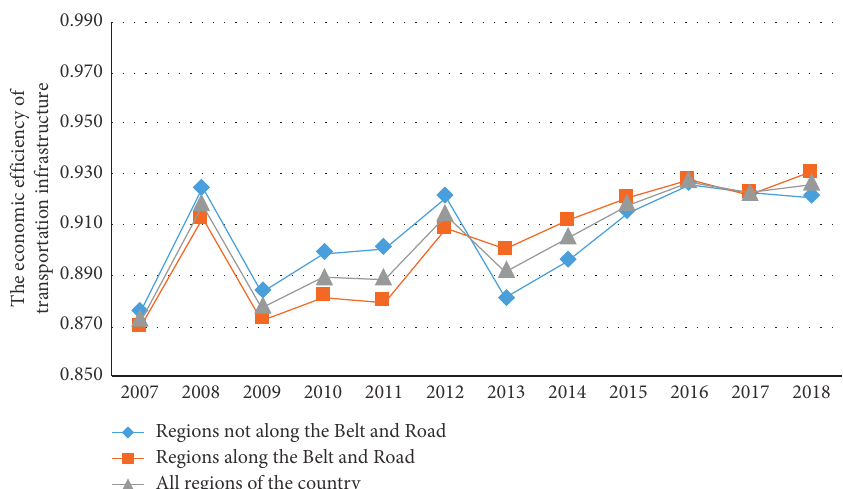
Figure 2: Trending in economic efficiency of transportation